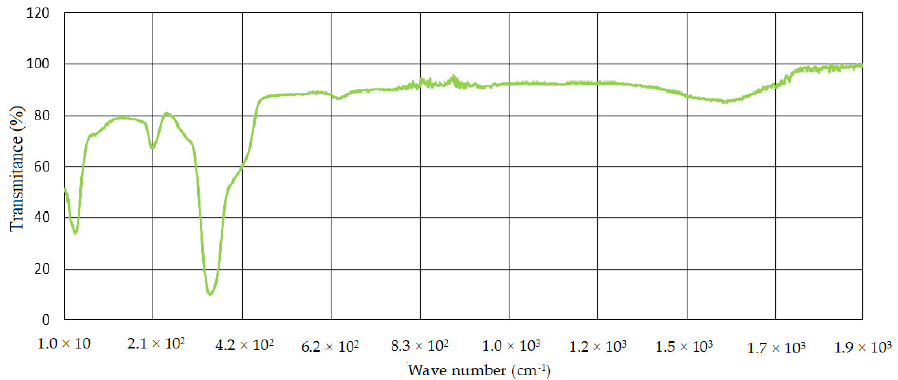
Figure 4. FT-IR (infrared spectroscopy) spectra of diatomite.